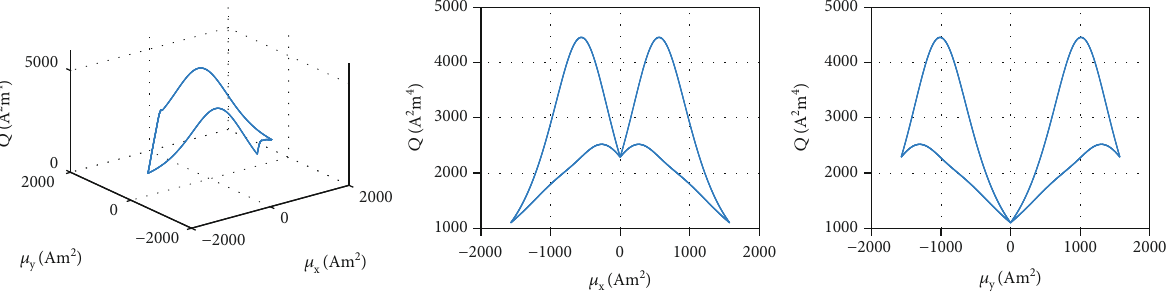
Figure 8: The desired force is [0.3N, 0.2N, 0] T .